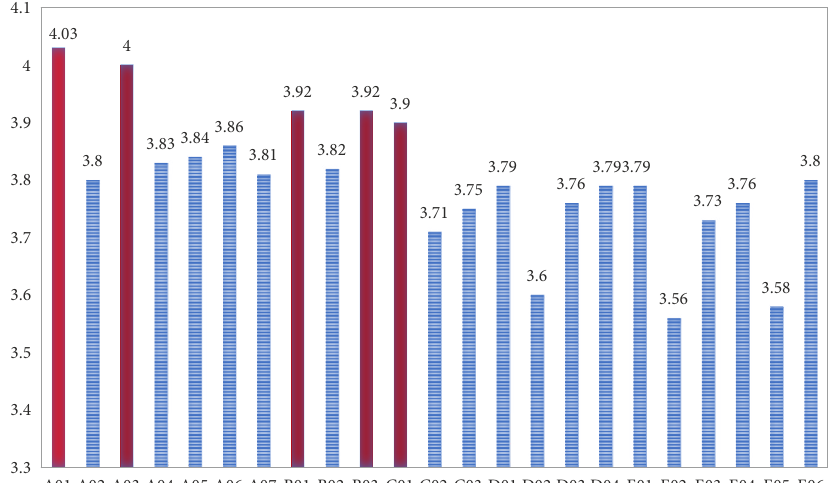
Figure 3. Mean value of factors that hinder the implementation of BIM in the background of building industrialization Table 5. Statistics table on the importance of lack of support